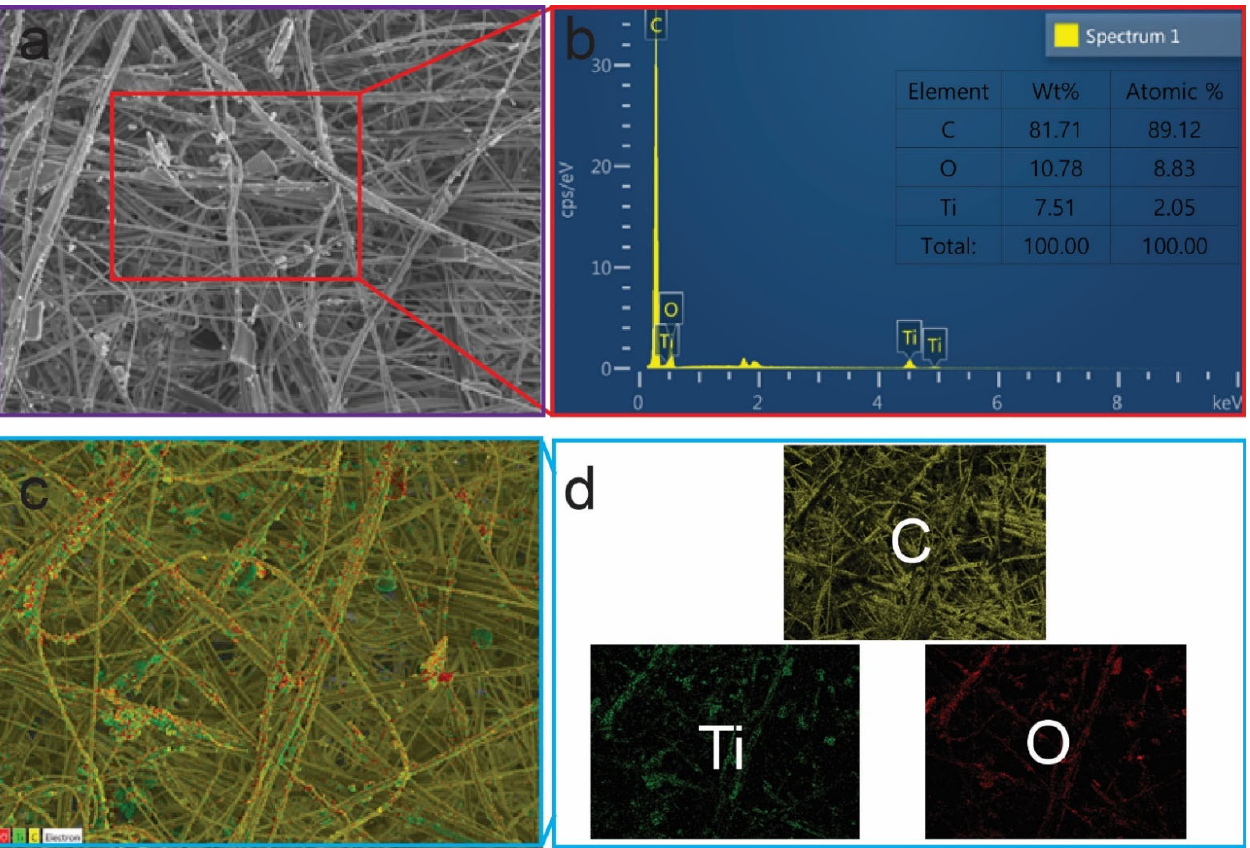
Figure 3. EDS ( a , b ) and elemental mapping ( c , d ) analysis of PPM + TiO 2 NPs. In addition, TEM was used to investigate the morphology and size of the TiO 2 NPs.